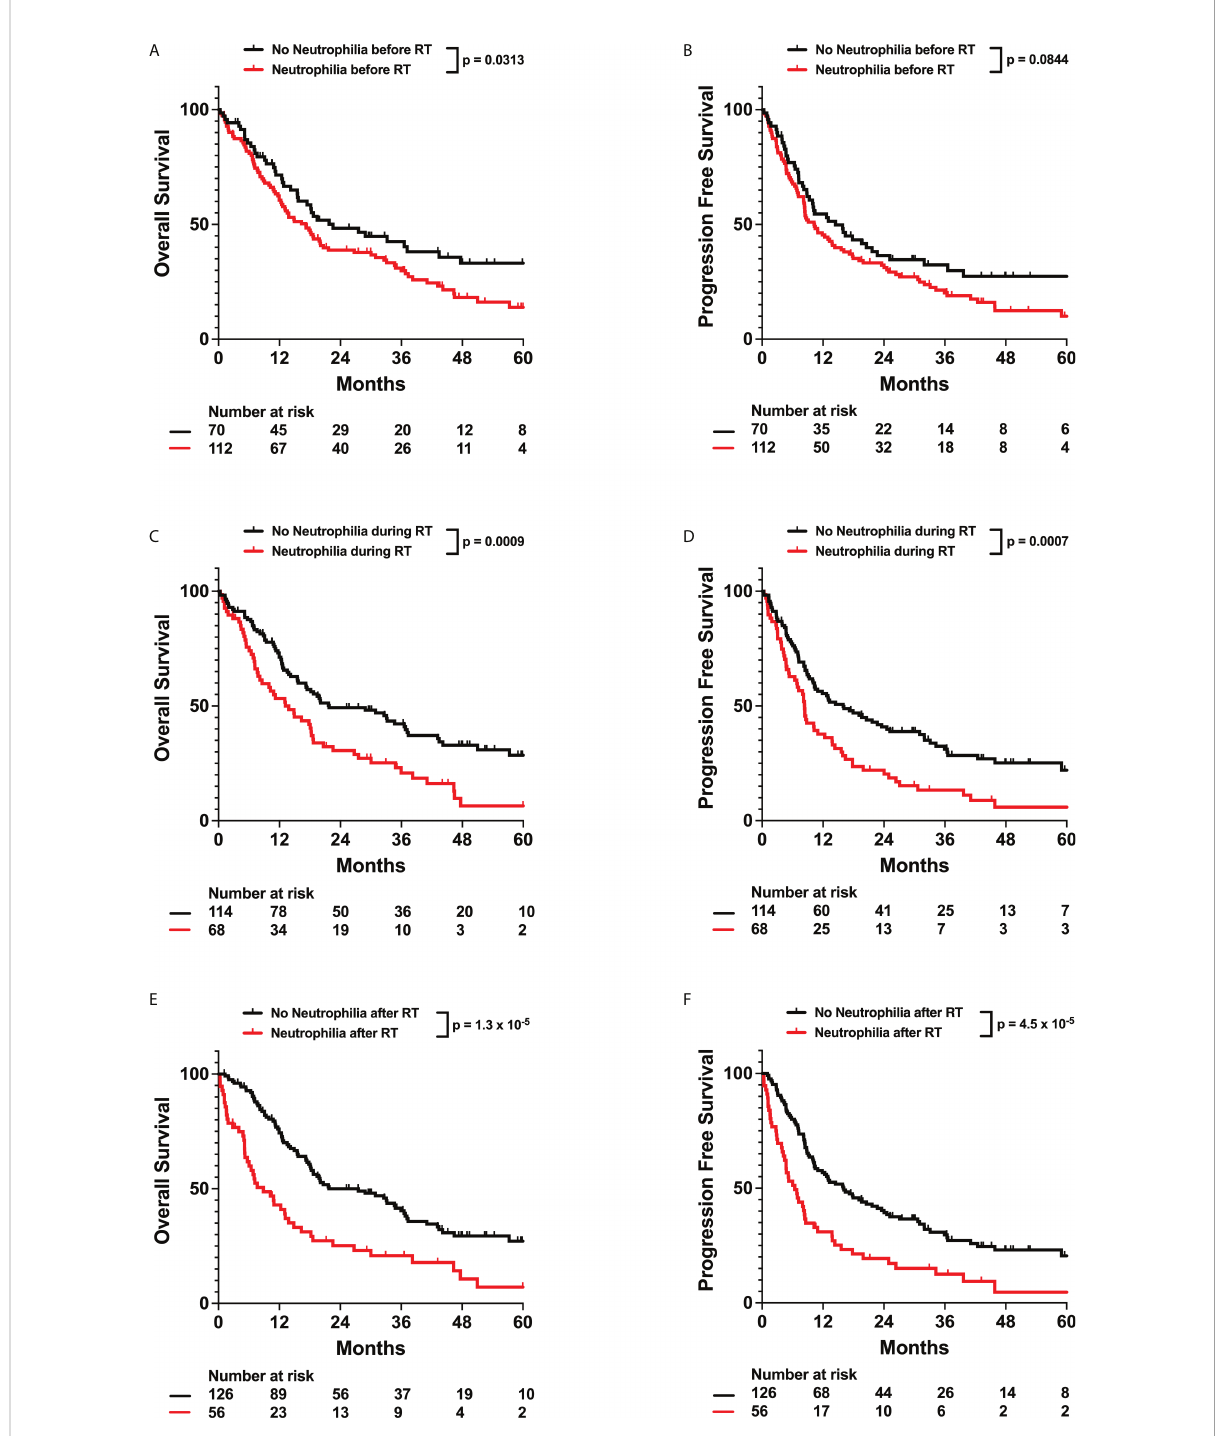
FIGURE 2 Effects of Neutrophilia on OS and PFS. Kaplan-Meyer plots of OS and PFS comparing patients with neutrophilia (A, B) before, (C, D) during, (E, F) or after radiation treatment. Statistical analysis was performed using Cox Proportional Hazards tests. OS, Overall Survival; PFS, Progression Free Survival; RT, Radiation